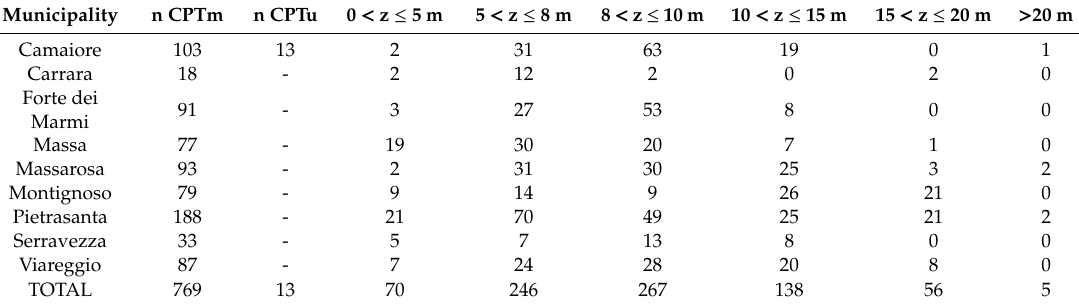
Table 1. Cone penetration test (CPT) database for the macro-area of Versilia.